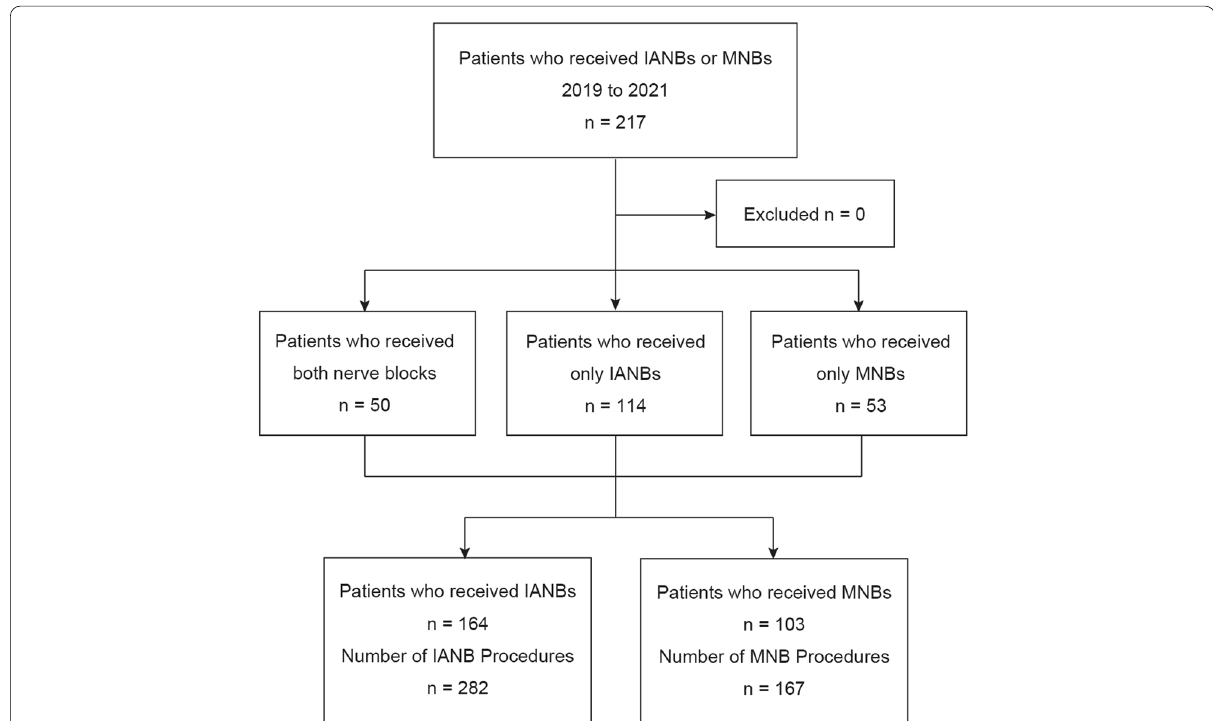
Fig. 1 Flow diagram of the study population. IANB ultrasound-guided inferior alveolar nerve block, MNB ultrasound-guided maxillary nerve